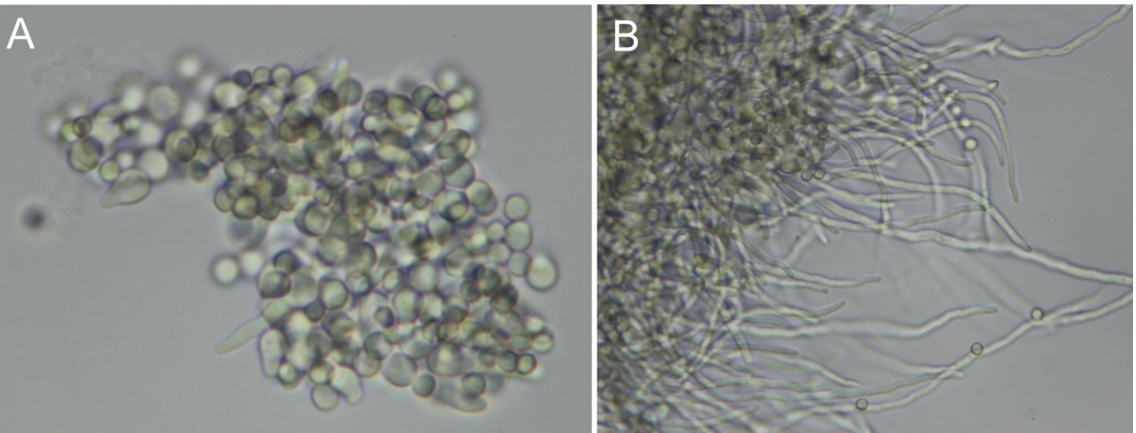
Figure 2. Asynchronous germination of A. fumigatus conidia. Fungal hyphae development 7 h ( A ) and 10 h ( B ) postinoculation. The time course of conidial germination in flask cultures was recorded by bright-field microscopy at 60 ×